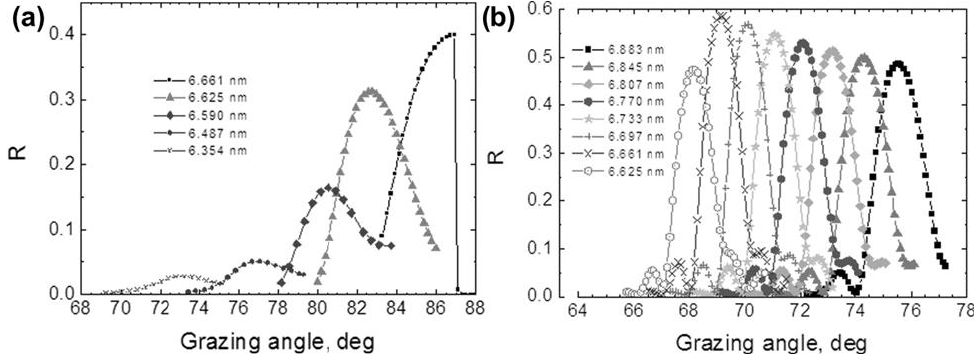
Figure 8. Angular dependence of reflectivity of ( a ) the La/B 4 C, and ( b ) La/B 4 C/C PMMs taken in the spectral range of 6.6 – 6.9 nm wavelengths. Reprinted from [32] with the permission of AIP Publishing.